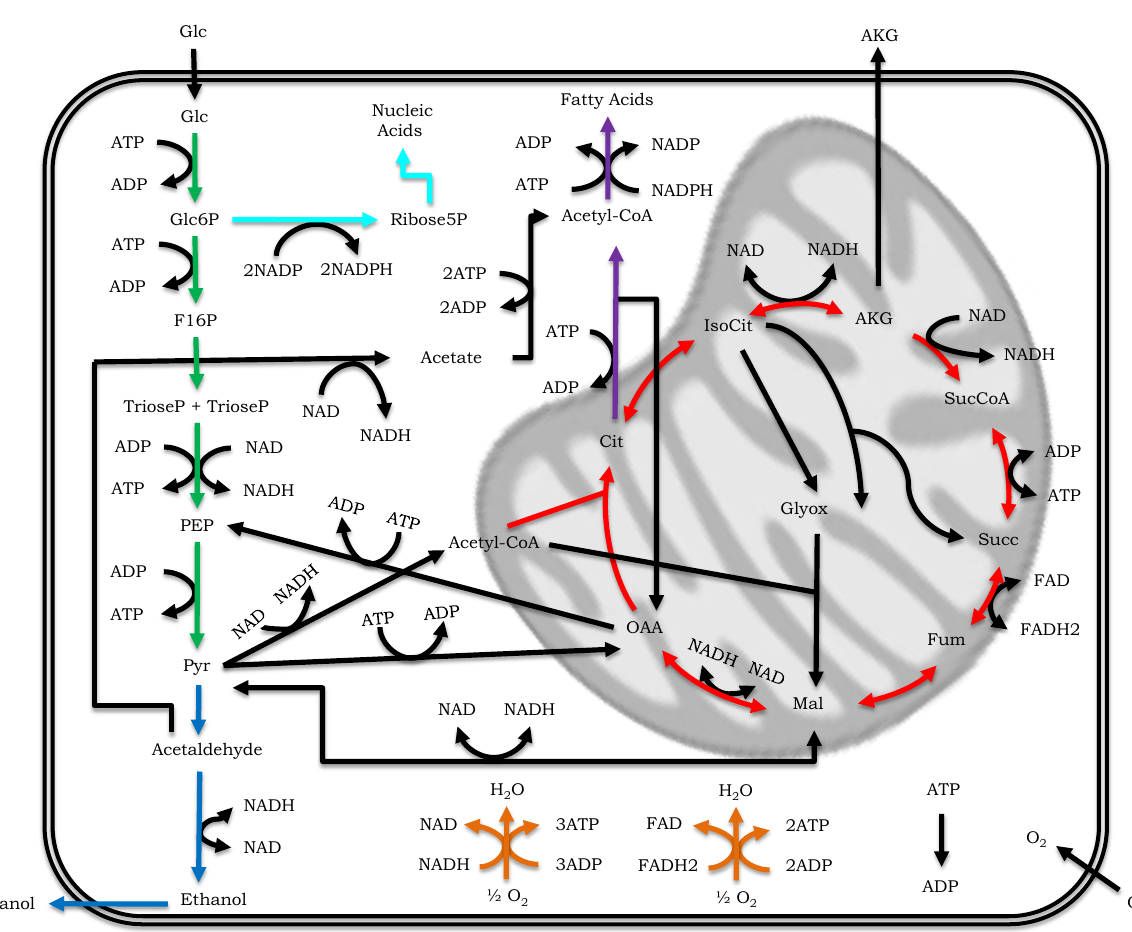
Figure 3. Example of core model representing the main metabolic pathways of yeast (modified from [65]). The pathways included in this example are: glycolysis (green arrows), ethanol fermentative pathway (blue arrows), pentose phosphate pathway (light blue arrows), fatty acids biosynthesis (violet arrows), tricarboxylic acid (TCA) cycle (red arrows) and oxidative phosphorylation pathway (orange